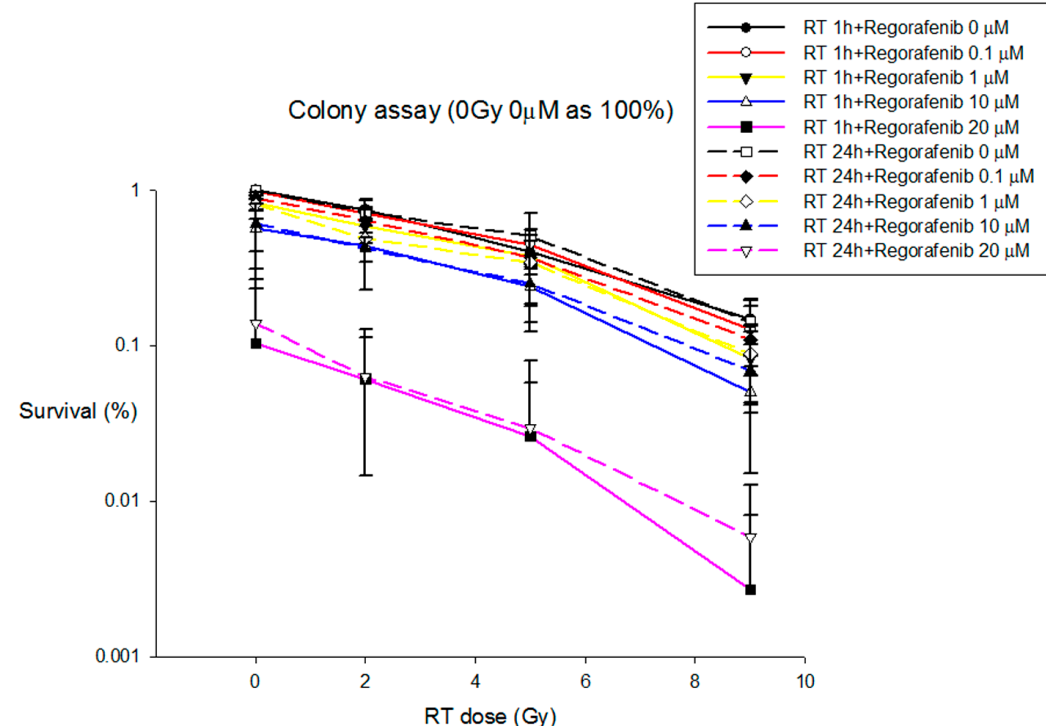
Figure 7. The colony formation analysis for HA22T line that were treated with indicated concentrations (from 0.1 to 20 µM) of regorafenib and RT (2 and 9 Gy), respectively. Data from three separate experiments are expressed as the mean ± standard error of the mean (SEM).